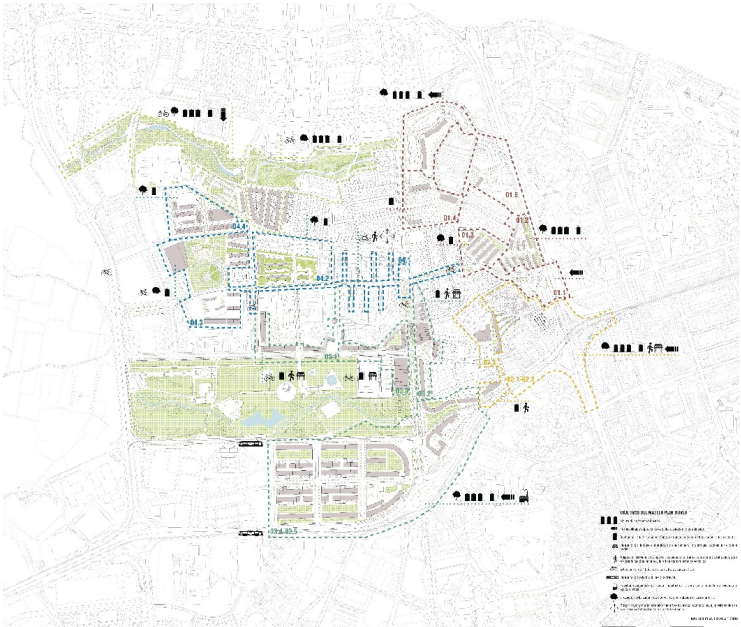
Figure 5. Objectives in the Oliver Neighbourhood. Presentation of the master plan (Students: S. Gómez & I. Maqueda)